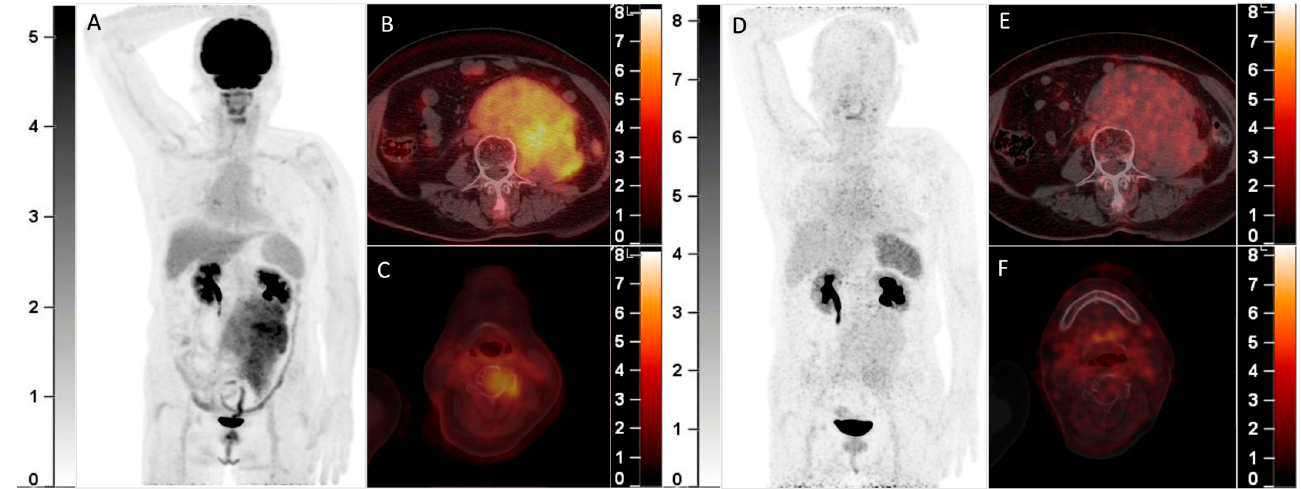
Figure 2. A 70 ‐ year ‐ old woman with smoldering MM was found to have a solitary plasmacytoma in the frontal bone that was surgically resected one year ago. Recently, she complained of backache and was found with a retroperitoneal mass. Elevation of the monoclonal protein (19.0 g/L) and the presence of IgA ‐ λ in serum immunofixation electrophoresis and infiltration of plasma cells (17.5%) in bone marrow aspiration confirmed the recurrence of MM. 18 F ‐ FDG PET/CT was then performed. The MIP image ( A ) showed an FDG ‐ avid mass in the abdomen. The axial fusion images ( B , C ) showed the mass was located in the retroperitoneum with uneven FDG distribution ( B , SUVmax 5.7). Furthermore, several bone marrow lesions with increased FDG uptake and lytic bone destruc ‐ tion were found in the occipital bone, C4 vertebra, and right 8th rib ( C , SUVmax 4.1). She was also included in the clinical trial and underwent 68 Ga ‐ Pentixafor PET/CT ( D , MIP image; E , F , axial fusion images). However, the retroperitoneal mass and the bone marrow lesions did not demonstrate in ‐ creased uptake of 68 Ga ‐ Pentixafor. She then received chemotherapy against MM, and the